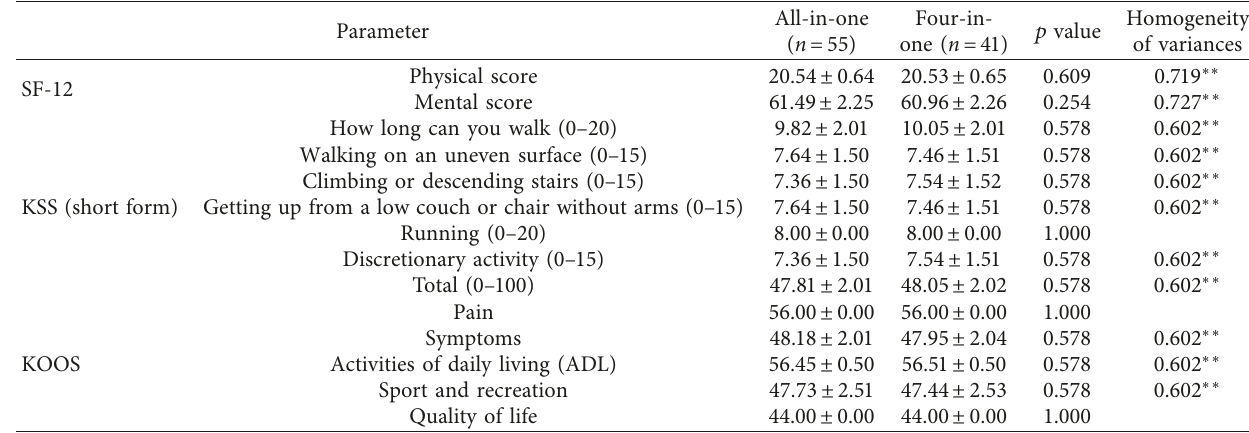
Table 2: Preoperative score comparison between all-in-one and four-in-one implant.